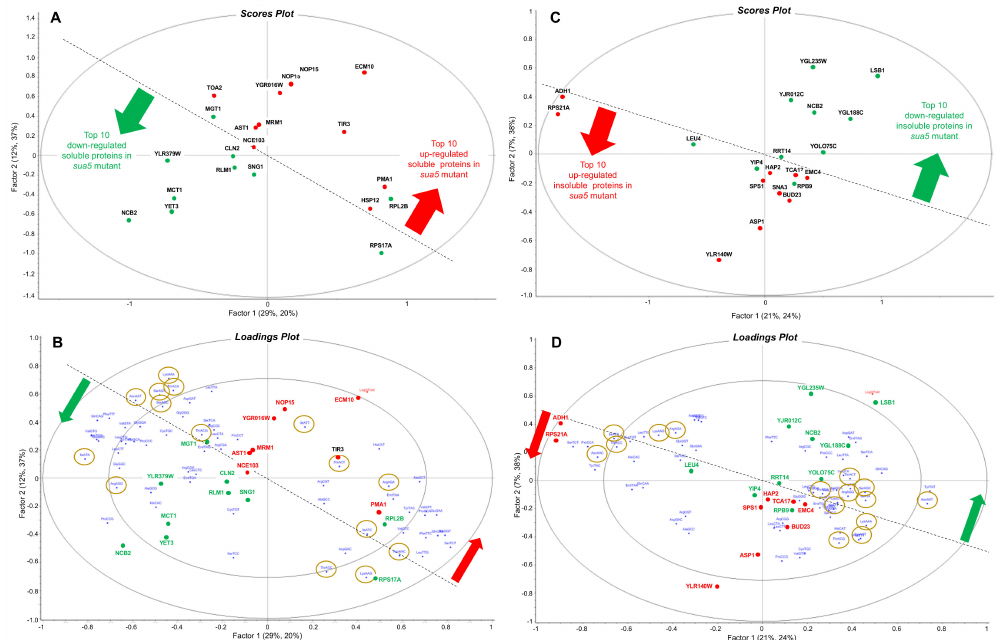
Figure 5. Partial least squares regression analysis of the association of codon usage with up- and down-regulated proteins in cells lacking Sua5. Soluble ( A , B ) and insoluble proteins ( C , D ) were isolated from wild-type and sua5 strains of S. cerevisiae and subjected to quantitative proteomics analysis. Codon usage in the 10 most up- and down-regulated proteins in the sua5 strain compared to wild-type was quantified using the codon utilization tool [82]. Partial least squares regression analysis was performed on the proteomic fold-change values and the codon usage data, with the resulting scores plots ( A , C ) and loadings plots ( B , D ) colored as follows: red, up-regulated proteins; green, down-regulated proteins; gold circles, ANN codons read by t 6 A-containing tRNAs; dotted line highlights the distinction between up- and down-regulated proteins. Some proteins from the scores plot (those that do no mask codons) are transposed to the loadings plot to highlight codon